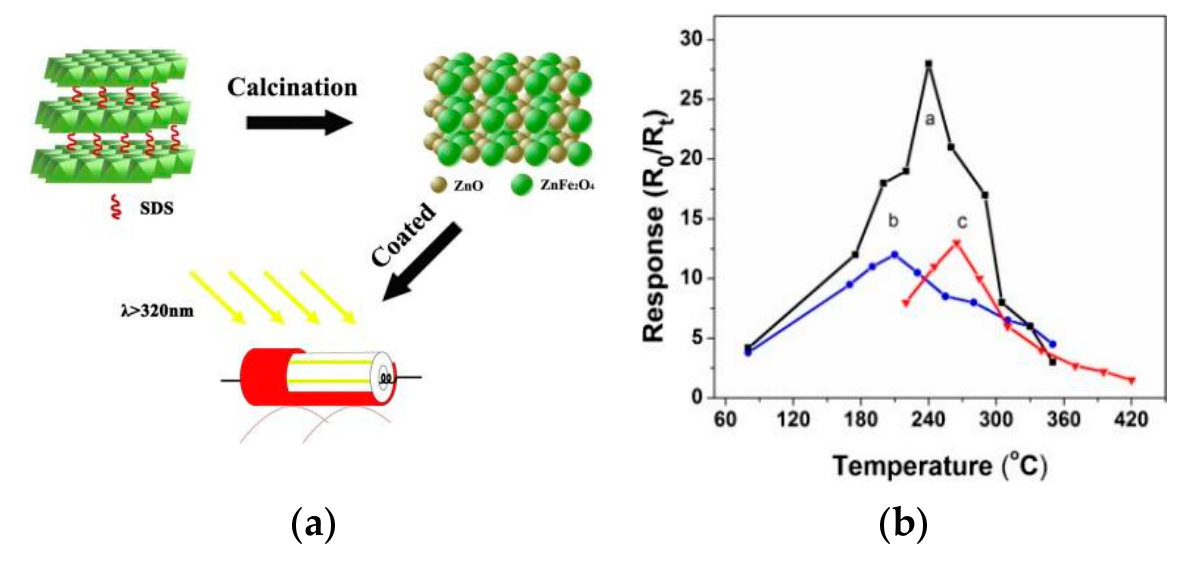
Figure 27. ( a ) The preparation and illumination of ZnO/ZnFe 2 O 4 . ( b ) The responses of ZnO/ZnFe 2 O 4 -600-a, ZnO/ZnFe 2 O 4 -800-b, and ZnO/ZnFe 2 O 4 -1000-c at various temperatures [168].